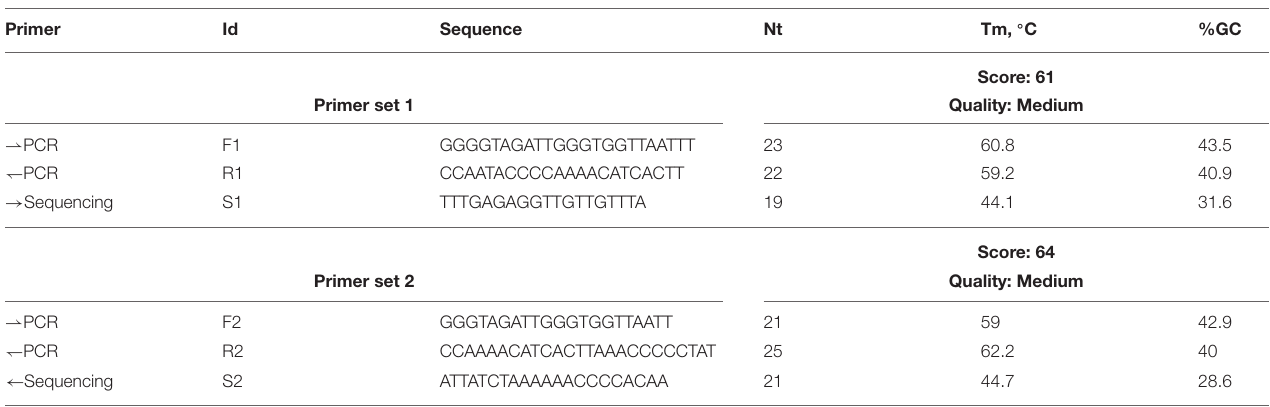
TABLE 1 | Primers for F1 (forward), R1 (reverse), S1 (sequencing primers) target region 1 and primers for F2 (forward), R2 (reverse), S2 (sequencing primers) target region